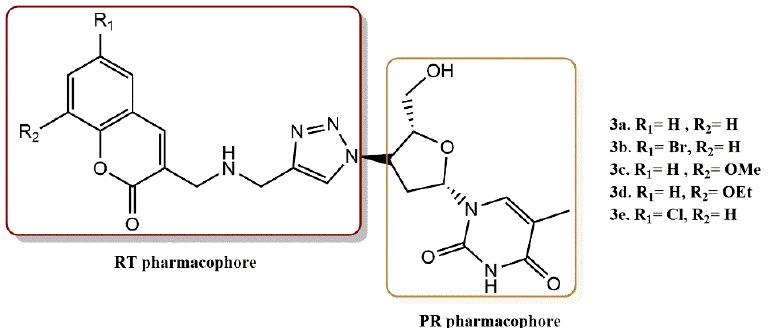
Figure 5. RT and PR pharmacophores of new active synthesized compounds 3a-e .